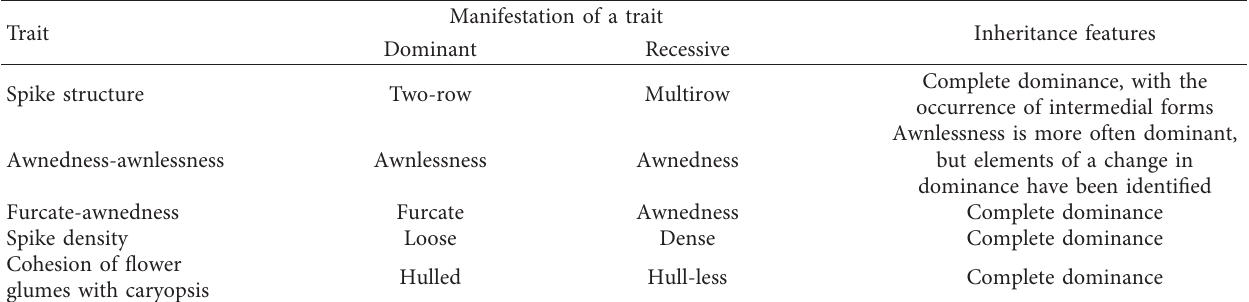
Table 5: Inheritance of morphological traits of barley and their manifestation in F